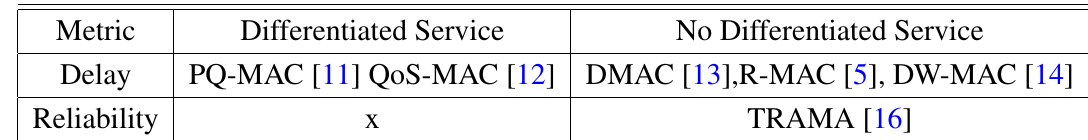
Table 1. Addressed QoS metrics and differentiated service support by the existing duty cycle MAC